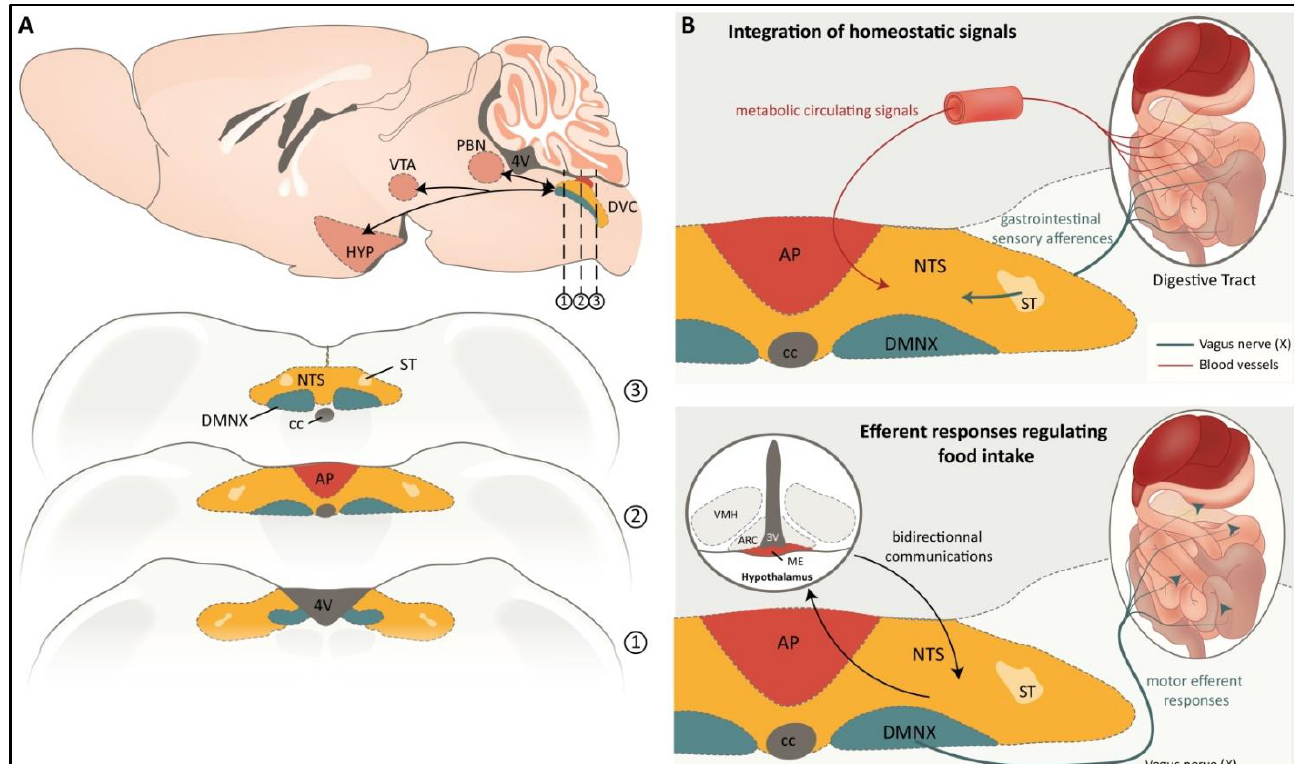
Figure 1. ( A ). A schematic illustration of DVC in the rodent brain, exhibiting its anatomic and functional architecture. The DVC is a brainstem structure located in the vicinity of the 4th ventricle and connected to several centers in the midbrain and forebrain (upper panel). The lower panel illustrates three DVC anatomic levels on coronal sections, i.e., rostral (1), postremal (2), and caudal (3) NTS. ( B ). The NTS integrates gastrointestinal information conveyed by both the vagal sensory afferents and the blood stream (upper panel). Bidirectional communication between the NTS and midbrain and forebrain nuclei, as well as vagal efferents to the gastrointestinal tract, are involved in efferent responses that regulate food intake and energy balance (Lower panel). 3V: 3rd ventricle, 4V: 4th ventricle, ARC: arcuate nucleus, AP: area postrema, cc: central canal, DMNX: dorsal motor nucleus of the vagus nerve, DVC: dorsal vagal complex, ME: median eminence, HYP: hypothalamus, NTS: nucleus of solitary tract, PBN: parabrachial nucleus, ST: solitary tract, VMH: ventromedial hypothalamus, VTA: ventral tegmental